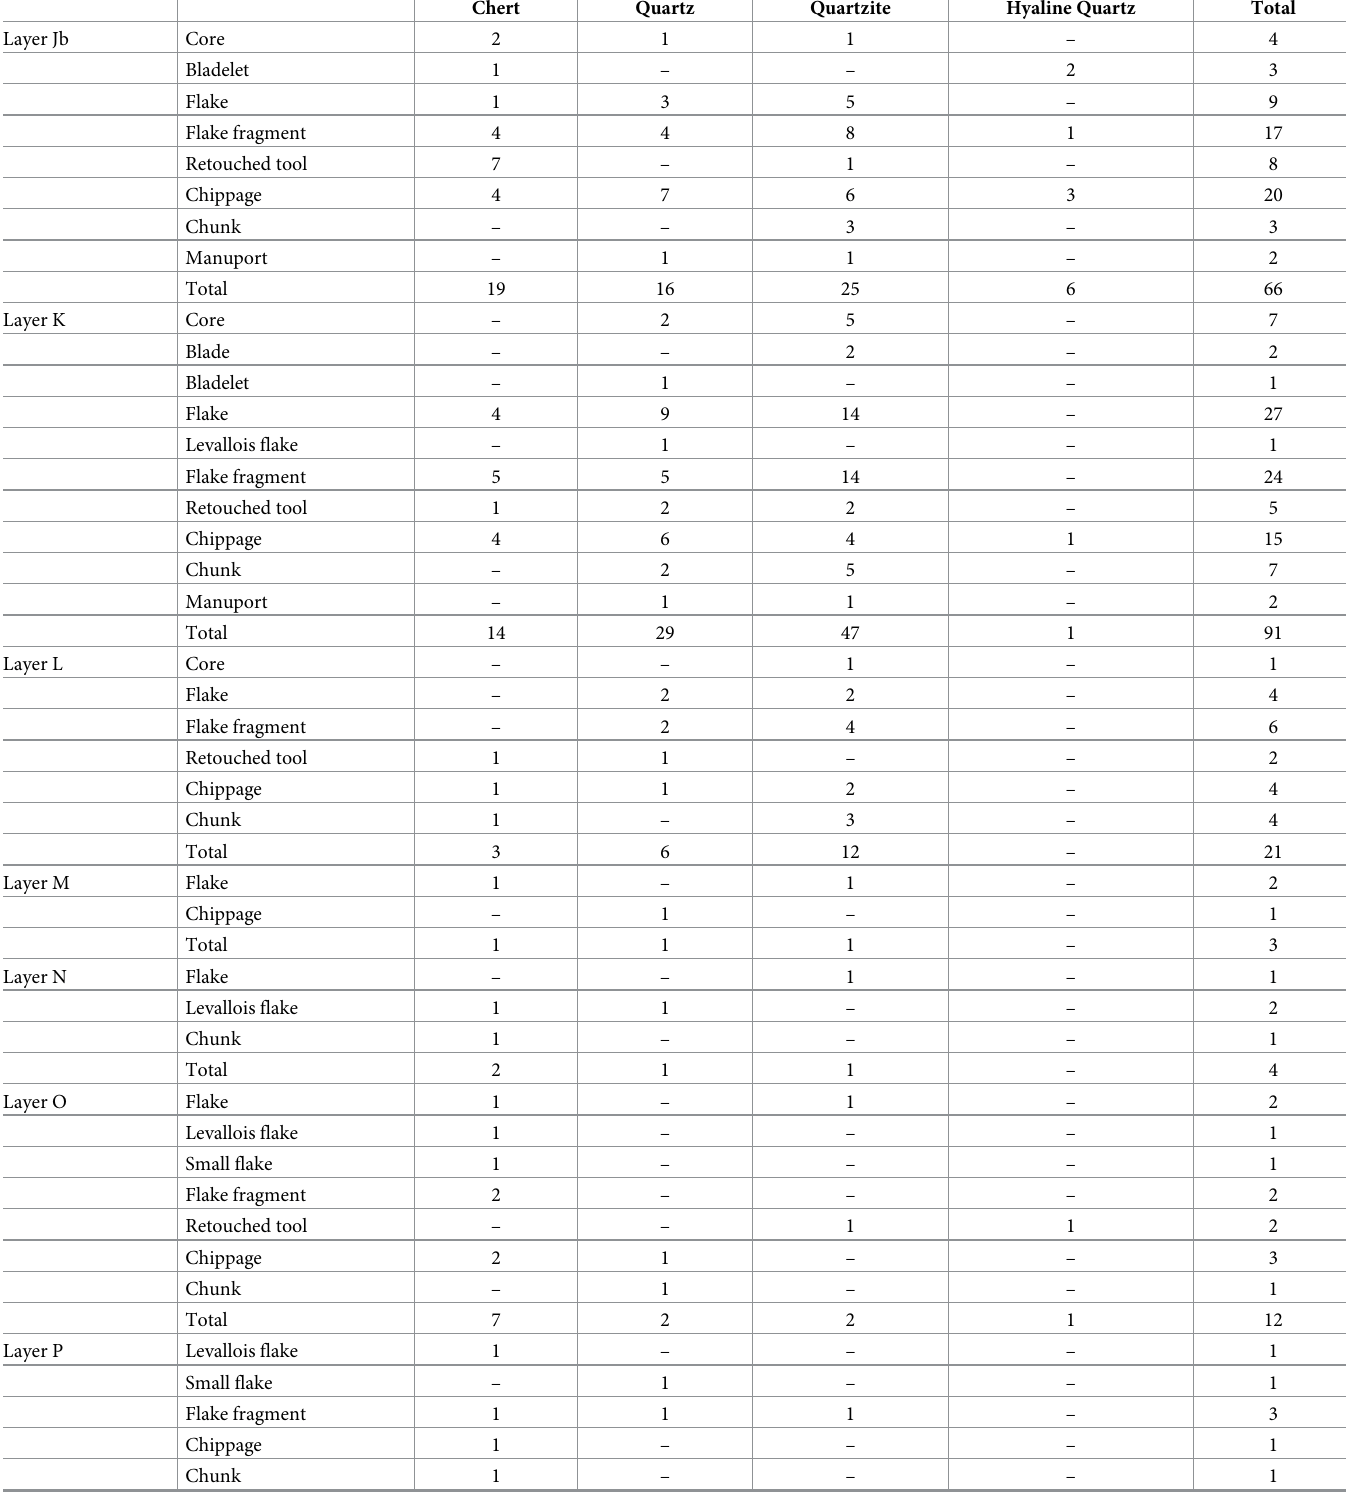
Table 2. Back chamber stone tools (layers